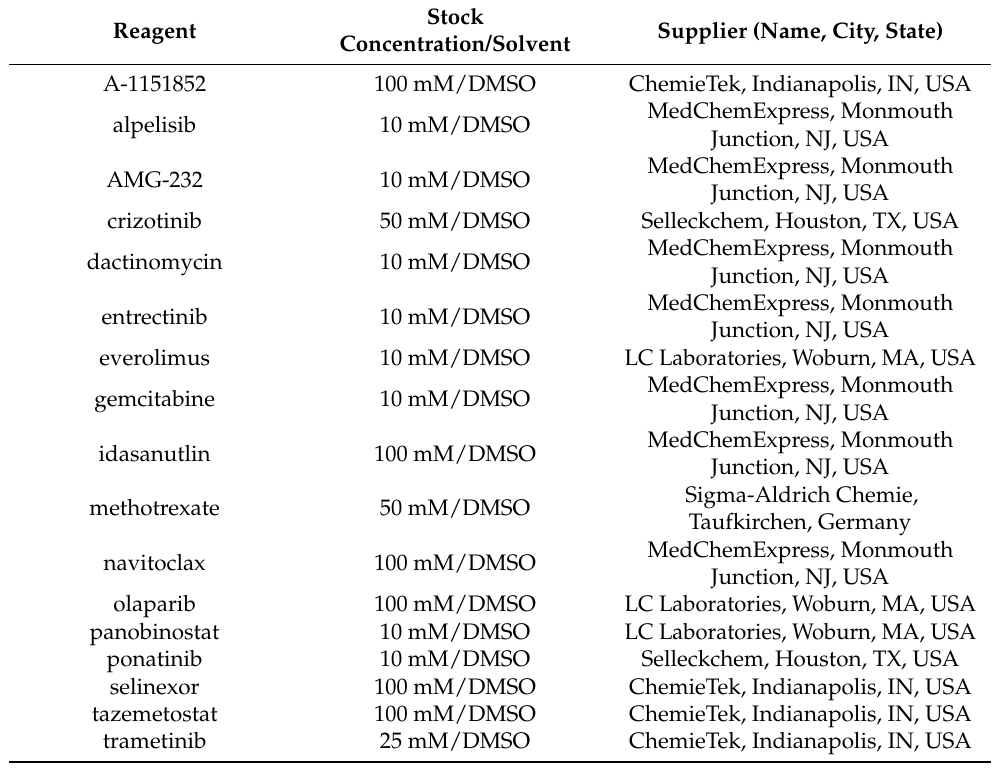
Table 2. Reagents used for the treatment of the zebrafish-xenograft